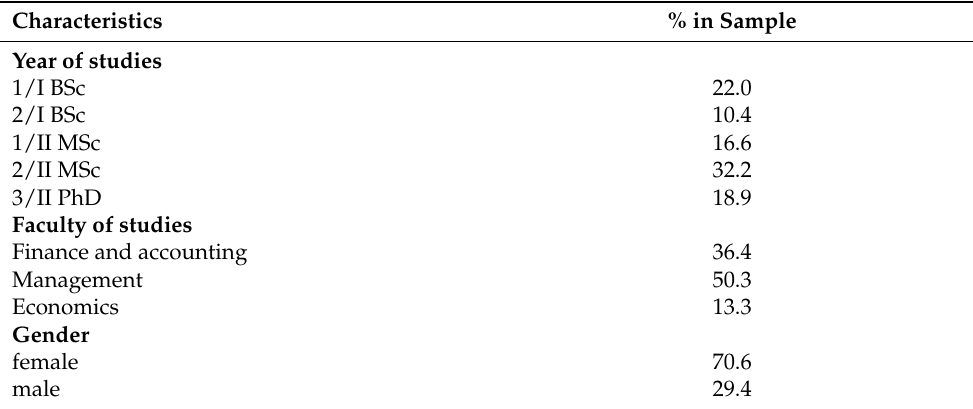
Table 1. Structure of the